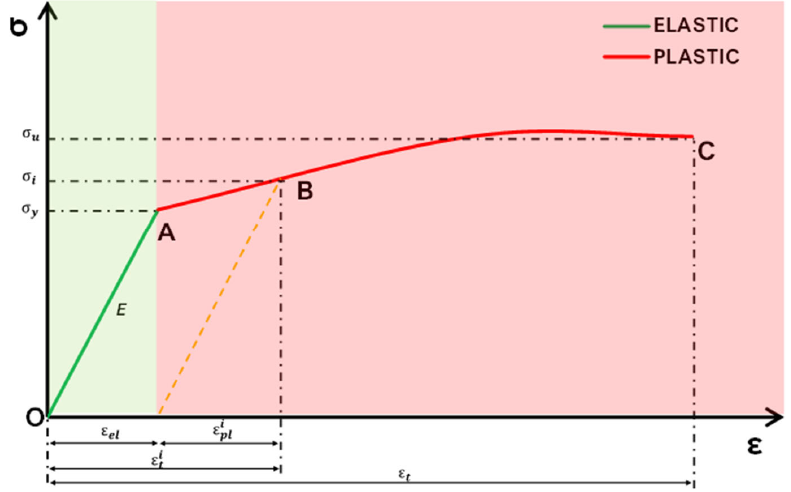
Figure A2. PP stress ‐ strain relationship.